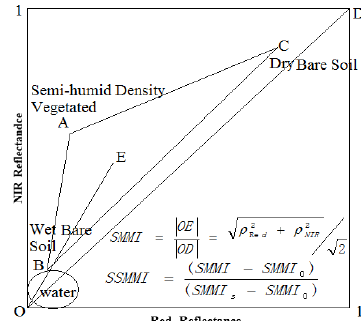
Figure 2. Sketch map of Scaled Soil Moisture Monitoring Index